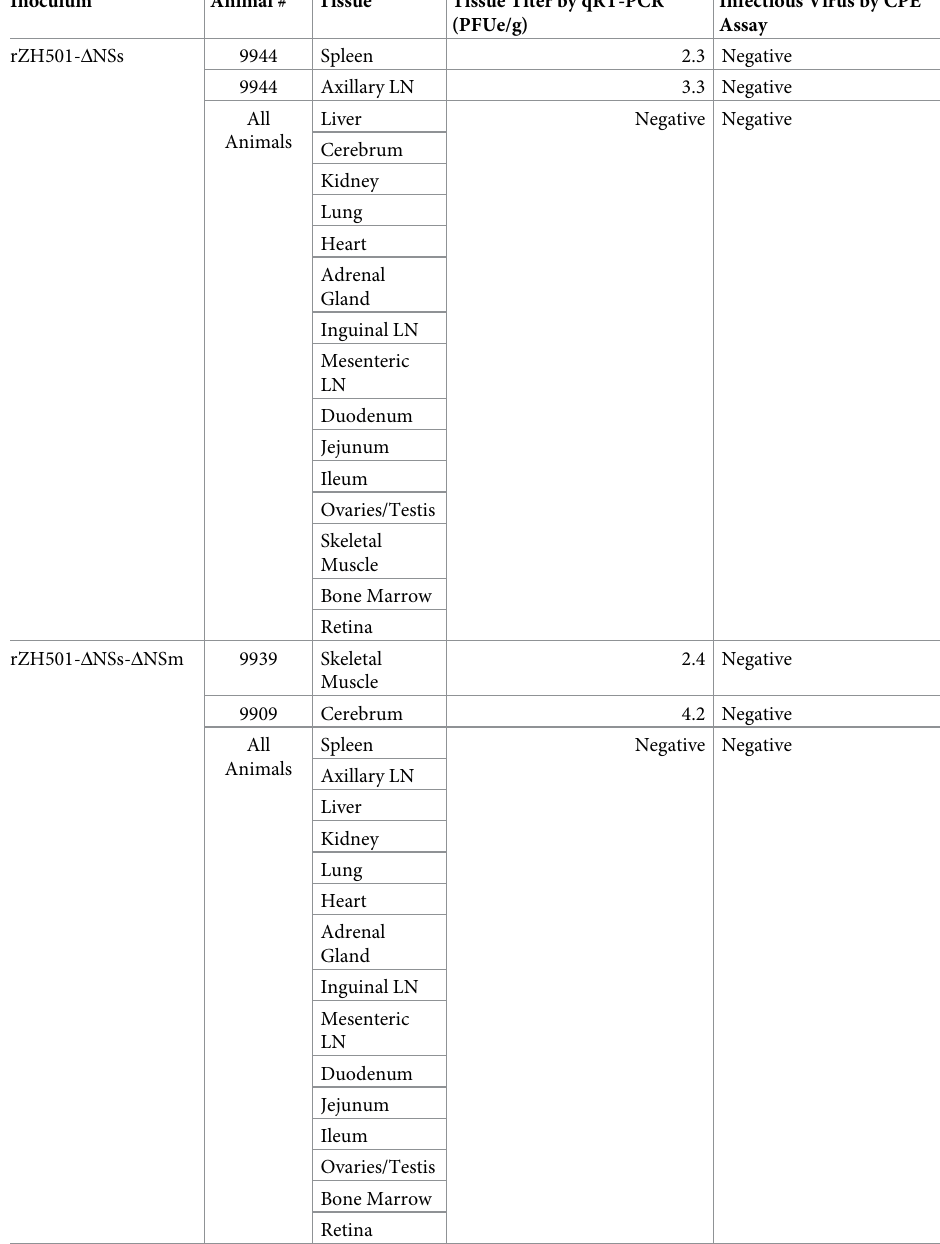
Table 3. Virus detected in the tissues of marmosets by qRT-PCR or CPE assay at the study endpoint.